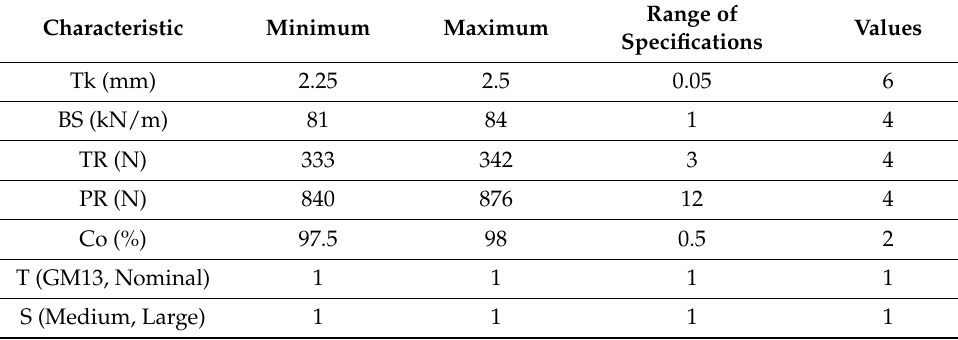
Table 5. Suitable ranges of geomembrane